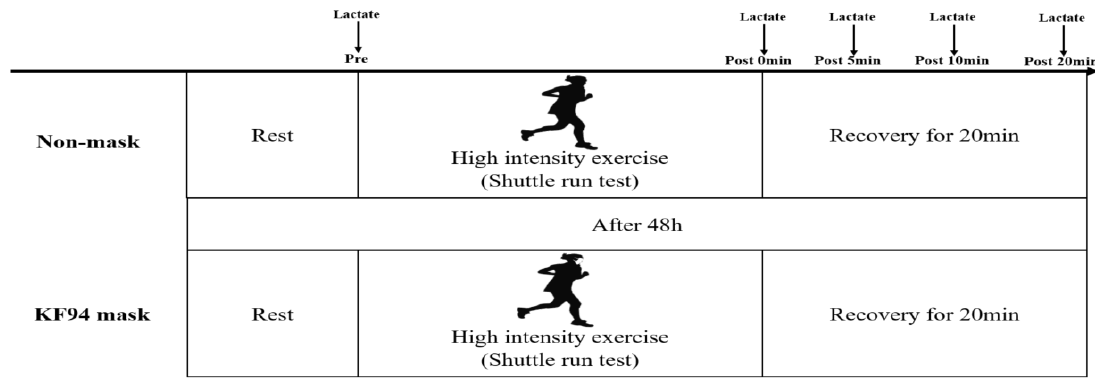
Figure 1. Timeline of the study.